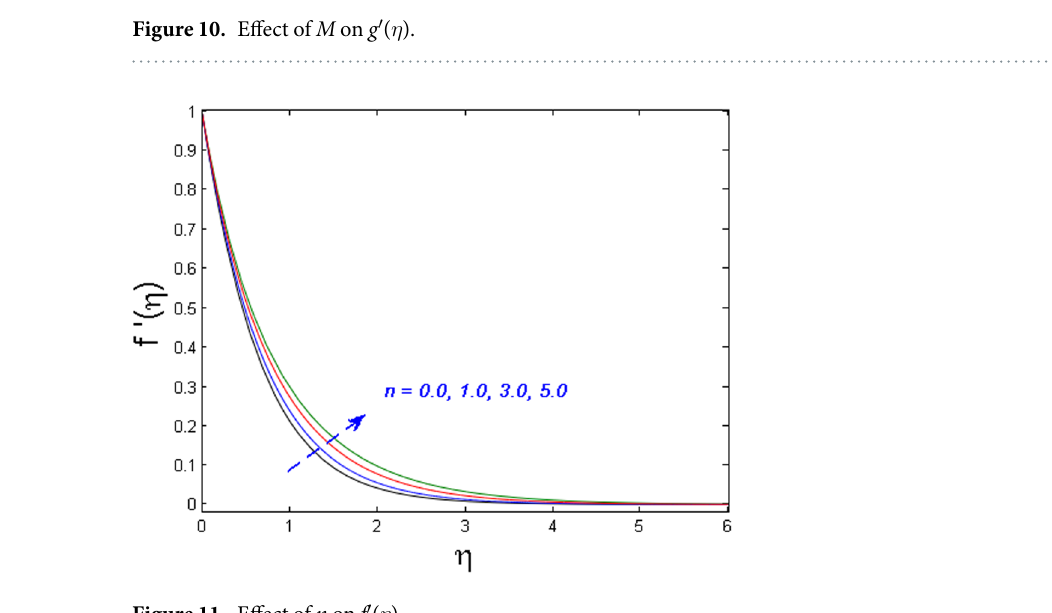
Figure 11. Effect of n on f ′ ( η ).